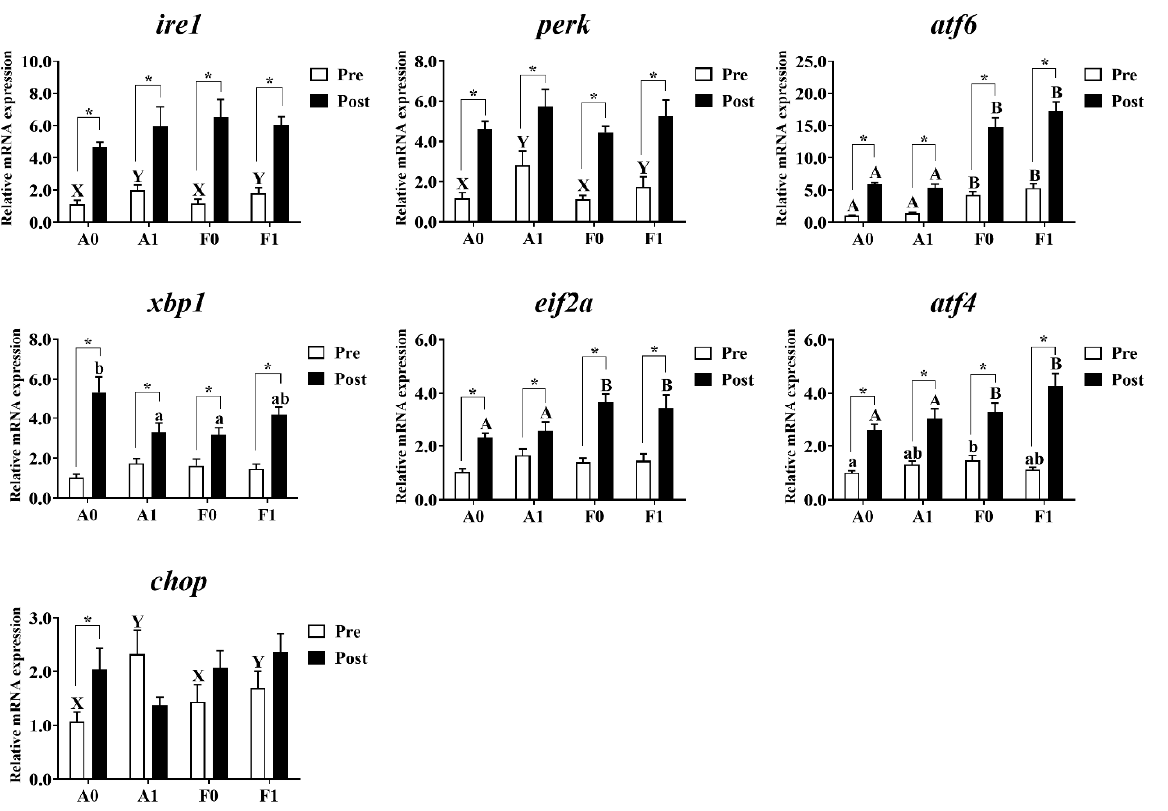
Figure 7. Expression levels of genes related to ER stress in the livers of gibel carp (A and F strains) before cadmium exposure (white bars) and after cadmium exposure (black bars). A0: A strain fed the control diet; A1: A strain fed a diet supplemented with taurine; F0: A strain fed the control diet; F1: A strain fed a diet supplemented with taurine. Bars with different uppercase letters (A, B) represent significant differences between the A and F strains ( p < 0.05). Bars with different uppercase letters (X, Y) represent significant differences between the control diet and taurine diet groups ( p < 0.05). Bars with different lowercase letters (a, b) indicate the interaction effect and represent the differences among all groups ( p < 0.05). Bars with * indicate significant changes between before and after cadmium exposure ( p < 0.05).